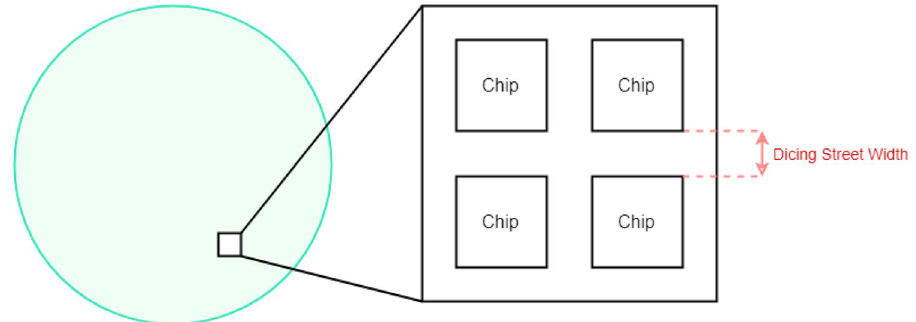
Fig. 4 Schematic diagram of scribing